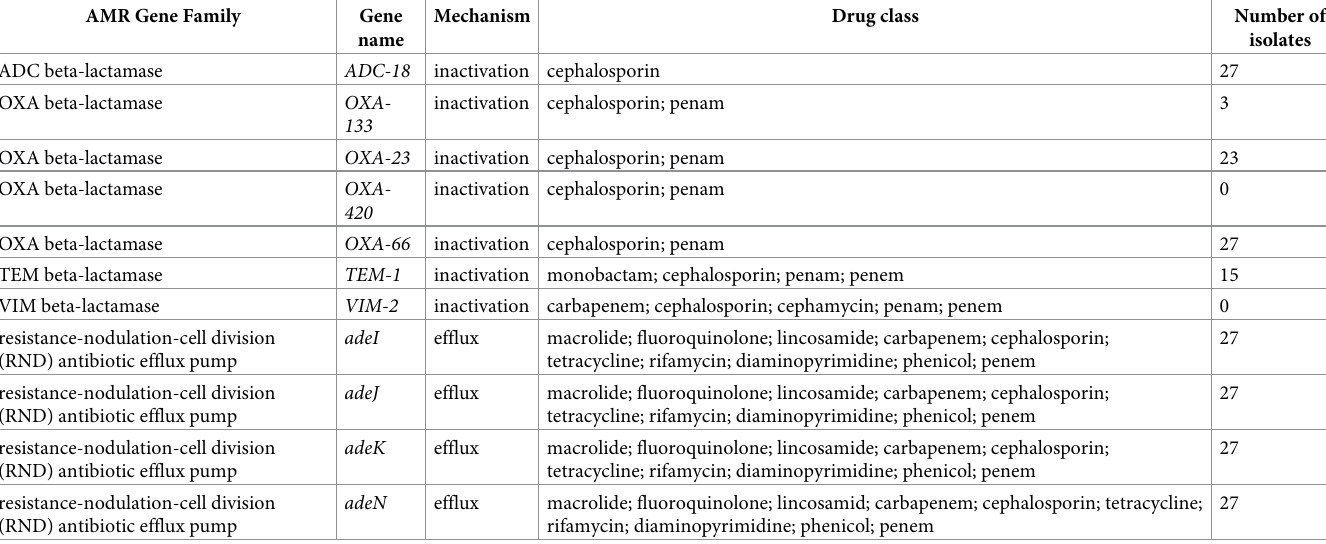
Table 1. Beta lactam resistance genes identified using whole-genome sequencing in 27 colistin-resistant A . baumannii . AMR Gene